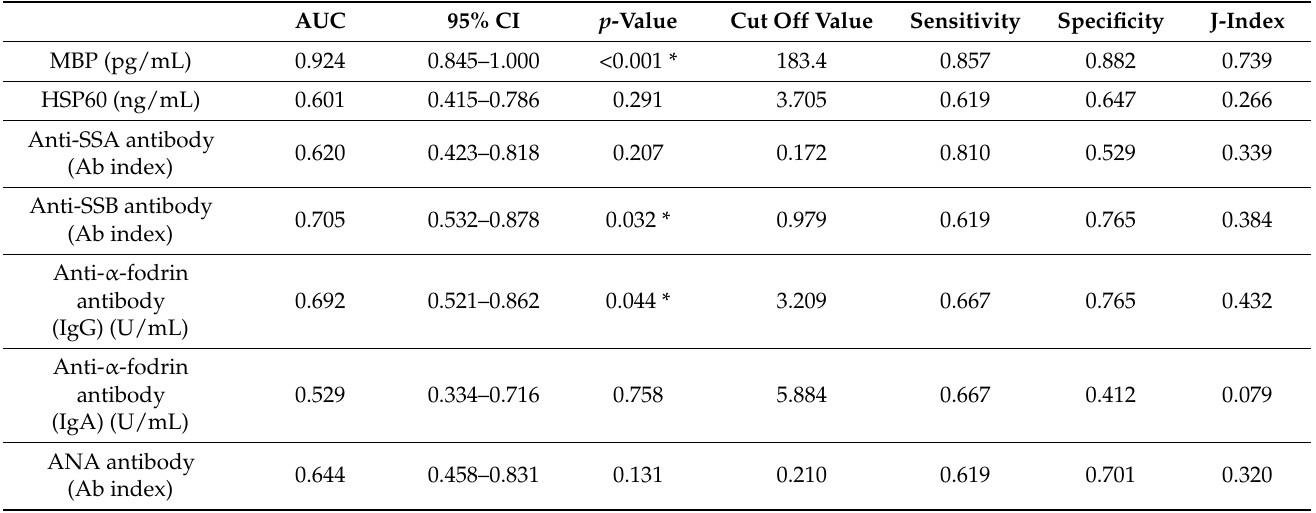
Table 2. Receiver operating characteristics curve analysis to discriminate between control and patients with glaucoma.